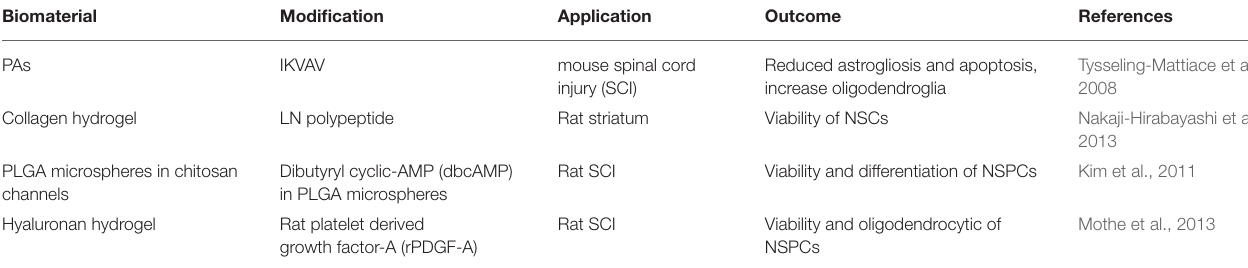
TABLE 2 | Biomaterial scaffold applied for neural tissue